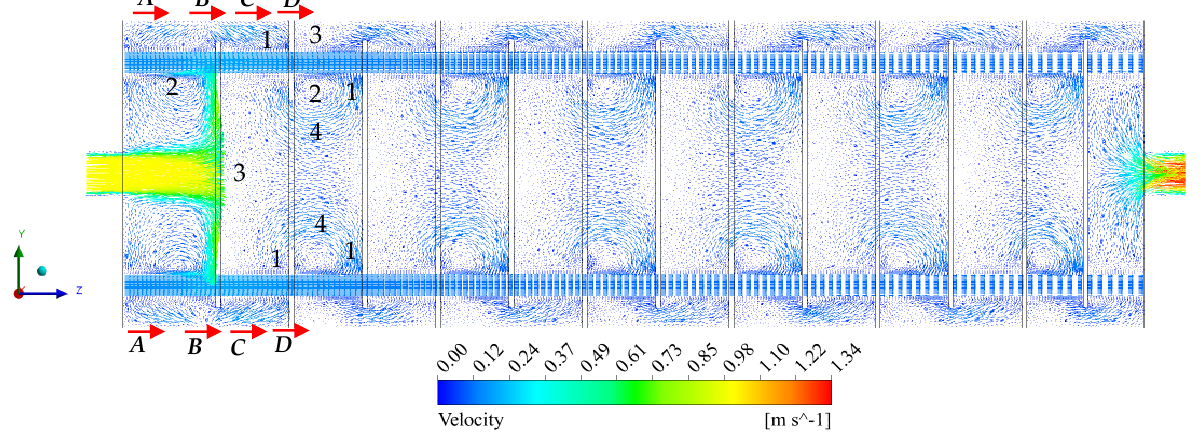
Figure 8. Reactor, longitudinal Velocity Flow field at X = 0, plane-YZ.